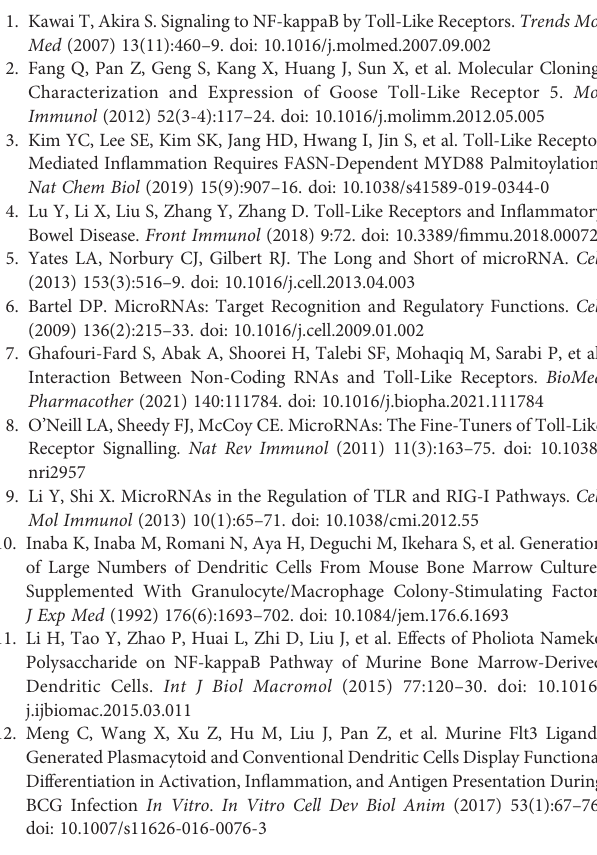
Supplementary Table S1 | Primers used for qRT-PCR analysis of miRNAs. Supplementary Figure S1 | Purity analysis of BMDCs by FCM. BMDCs generated from C3H/HeJ murine bone marrow progenitors were cultured in the presence of rmGM-CSF and rmIL-4. Next, the cells were harvested and sorted with anti-CD11c-coated magnetic beads using an auto-MACS system. The purity of the CD11c + BMDCs was analyzed using FCM by staining with PE-labeled CD11c. (A) BMDCs before sorting, (B) sorted BMDCs.